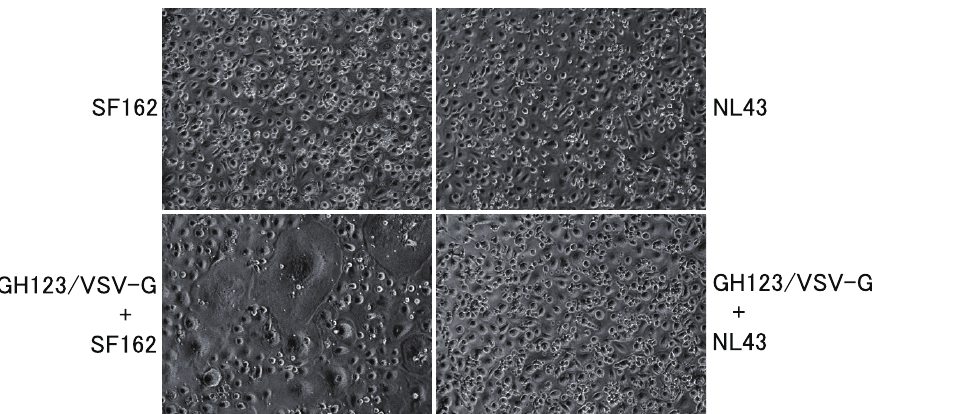
Figure 5. Syncytium formation in undifferentiated monocytes pretreated with HIV-2 particles and then infected with macrophage- tropic HIV-1. Monocytes were treated with VSV-G pseudotyped and Env-defective HIV-2 particles (GH123/VSV-G) and then infected with HIV-1 strain SF162 or NL43. Presented data are representative of two independent experiments.